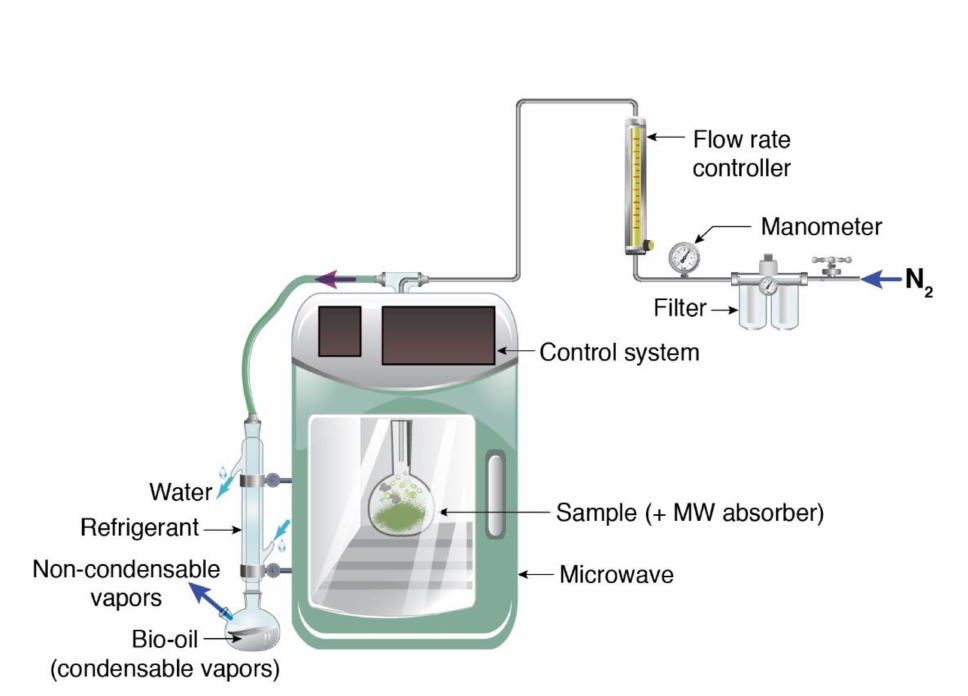
Figure 1. Experimental set-up for microwave-assisted pyrolysis of pine wood sawdust biomass. Given the low dielectric loss tangent of pine wood sawdust (tan δ = 0.11 for wood and tan δ = 0.18 for pine bark [25]), the feedstock has to be mixed with a suitable microwave absorber (here activated carbon (AC)) to reach high temperatures that are necessary for pyrolysis. 10 wt.% of AC was added